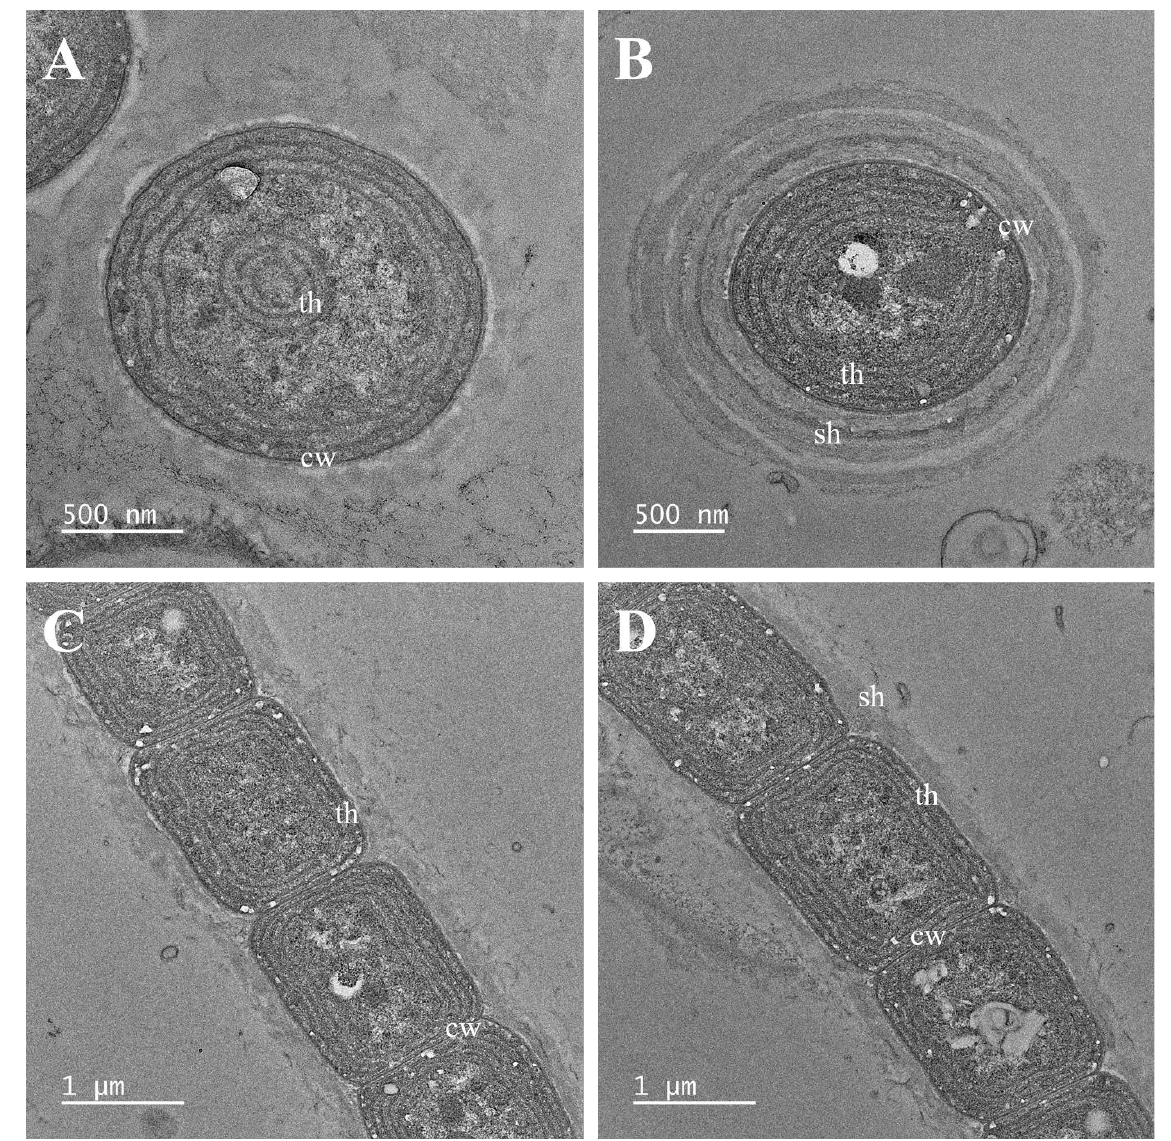
Figure 3. Transmission electron micrographs of Plectolyngbya terrestris strain FBCC-A1479. ( A , B ) Parietal thylakoids seen in the cross section. ( C , D ) Parietal thylakoids appearing in the longitudinal section. cw: cell wall; sh: sheath; th: thylakoids. Plectolyngbya koreana Kim D., Lee N., Yang E.C., and Lee O. sp. nov. (Figures 4 and